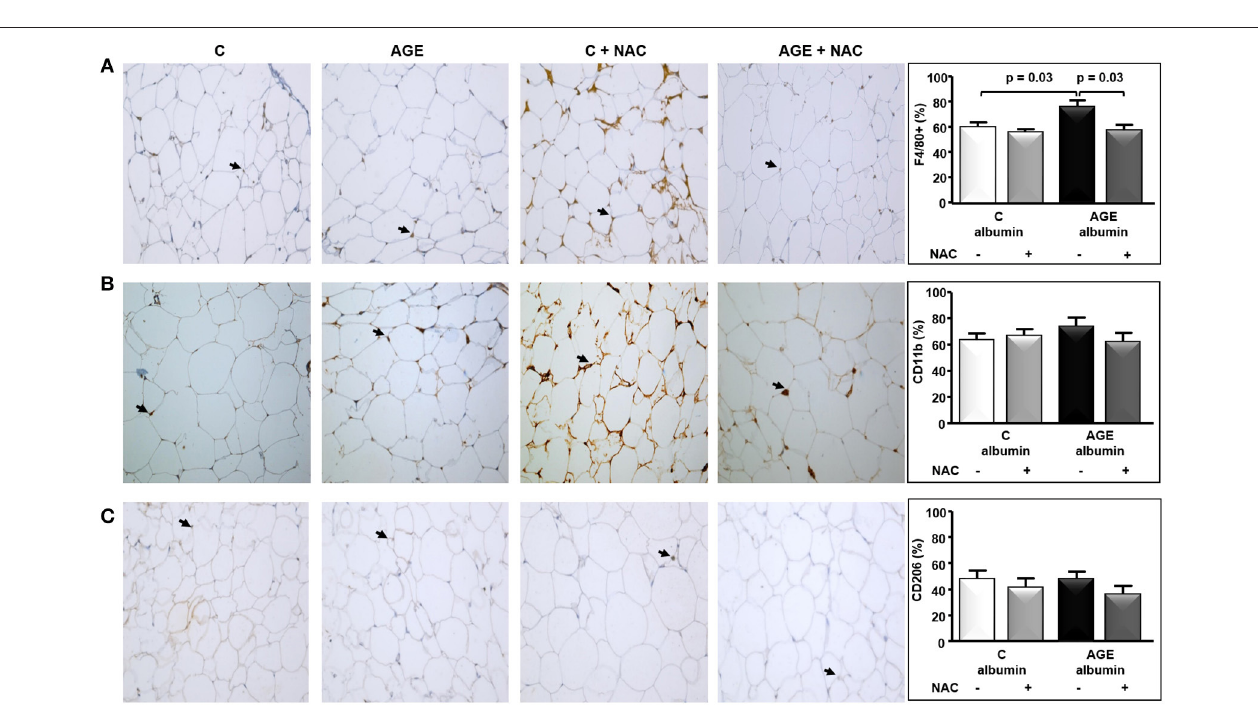
FIGURE 4 | Immunostaining for F4/80, CD11b, and CD206 in periepididymal adipose tissue. Periepididymal adipose tissue sections from animals treated with C-albumin ( n = 8), C-albumin + NAC ( n = 7), AGE-albumin ( n = 8) and AGE-albumin + NAC ( n = 7) were evaluated by immunohistochemistry. (A) Representative images of histological sections; black arrows indicate positive cells (macrophage) stained with antibody against F4/80 (Abcam 1:100); 400 X magnification. (B) Representative images of histological sections; black arrows indicate positive cells stained with antibody against CD11b, marker of M1-macrophage (Abcam 1:200); 400 X magnification. (C) Representative images of histological sections; black arrows indicate positive cells stained with antibody against CD206, marker of M2-macrophage (Abcam 1:1250) (400 X magnification). Representative graphics were obtained after stereological analysis. Results (mean ± SEM) were compared by One-way ANOVA with Newman-Keuls